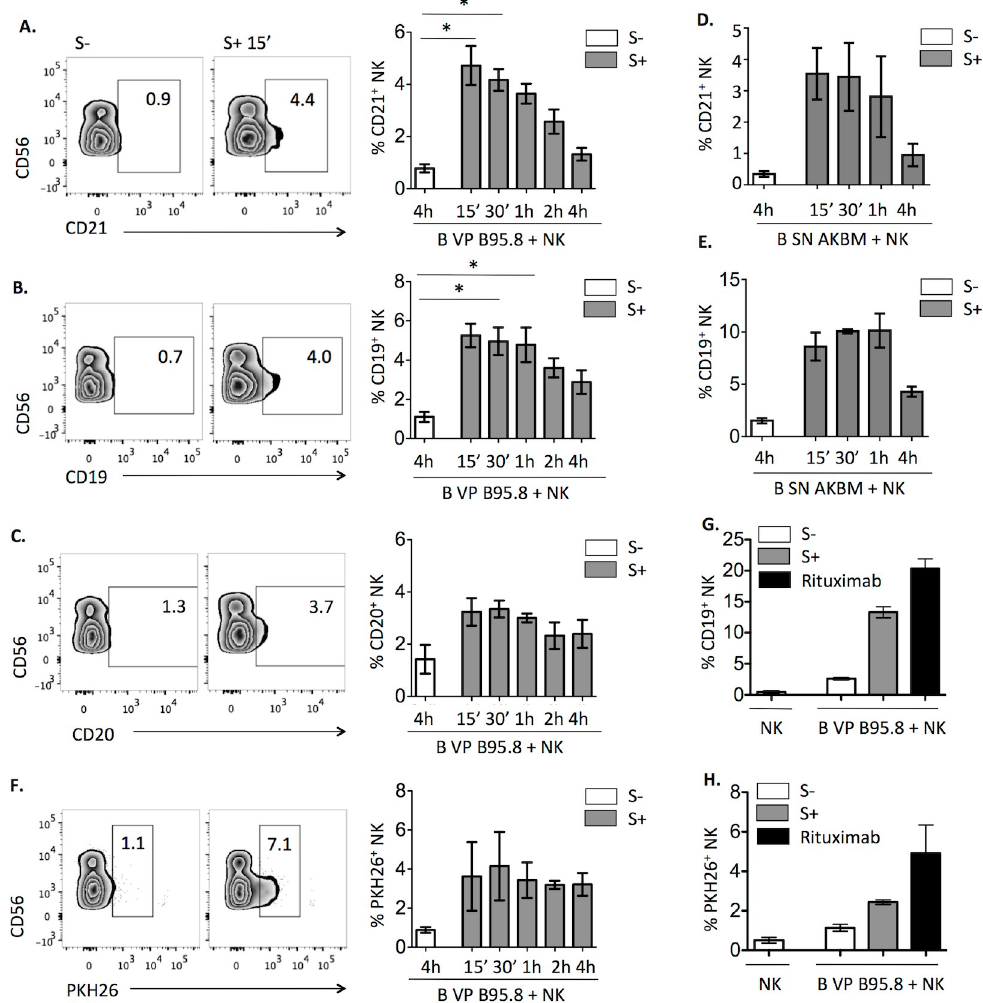
Fig 6. Transfer of B cell-bound EBV particles to NK cells is encompassed by trogocytosis. (A-E) B cells were coated with B95.8 VP ( A - C ) or AKBM VP ( D , E ), co-cultured with NK cells and EBV S- or S+ serum for the indicated times, and stained for CD21, CD19, CD20 and CD56. The proportions of CD21 + ( A, D ), CD19 + ( B, E ) and CD20 + ( C ) NK cells (gated as in Fig 4A) are shown. Representative plots of EBV S- at 4h and EBV S+ at 15min (left) and of four ( A-B ) and three ( C-E ) experiments (right) are displayed. Statistical analysis was performed with Friedman test with Dunn’s multiple comparison test. ( F) B cells were stained with 2 μ M PKH26, coated with B95.8 VP and co-cultured for the indicated times with NK cells and EBV S- or S+. Proportions of PKH26 + NK cells in representative plots of EBV S- at 4h and EBV S+ at 15min (left) and of three experiments are shown. ( G , H) B cells were treated and co-cultured as in ( F) but for 4h in the presence of EBV S-, EBV S+ or 12.5 ng/ml of Rituximab. The proportions of CD19 + (E) and PKH26 + (F) NK cells corresponding to two experiments are shown.